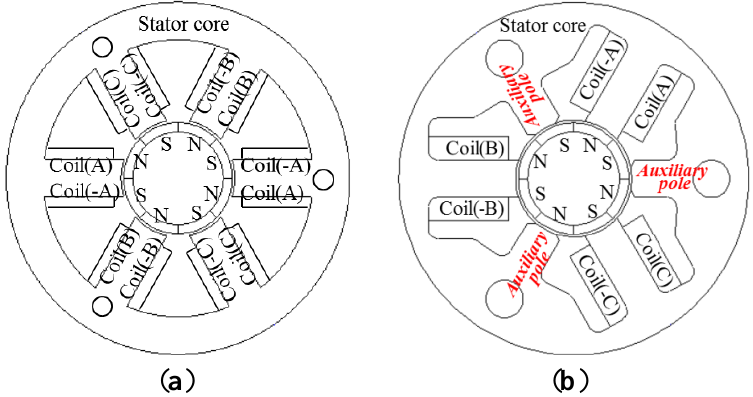
Figure 2. Stator-core shape of the AGS. ( a ) General motor type. ( b ) Proposed motor.